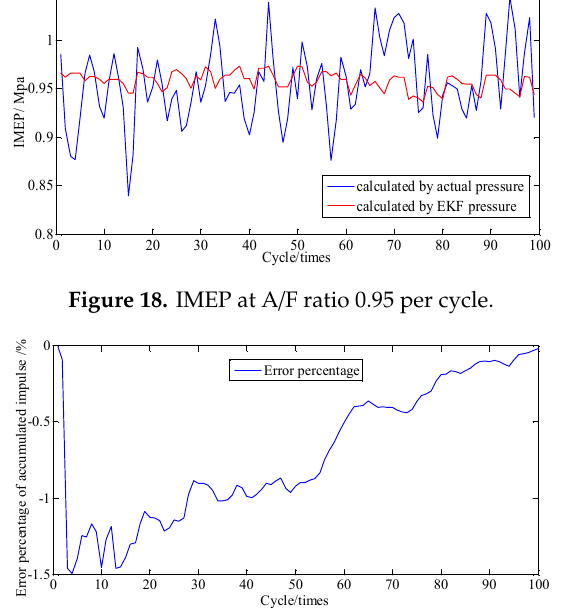
Figure 19. Error percentage of piston impulse accumulated.